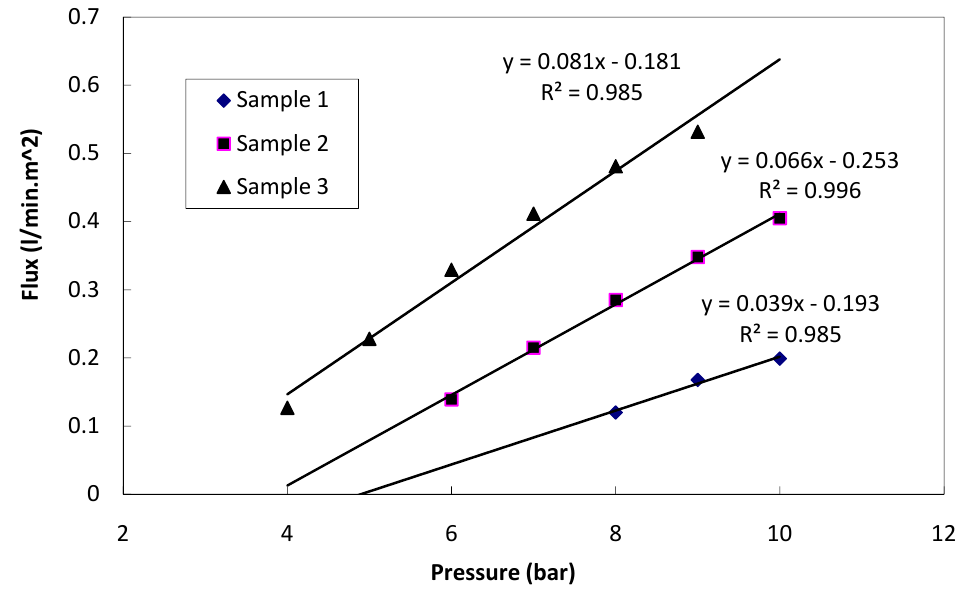
Figure 2. Permeate flux vs . pressure for the three